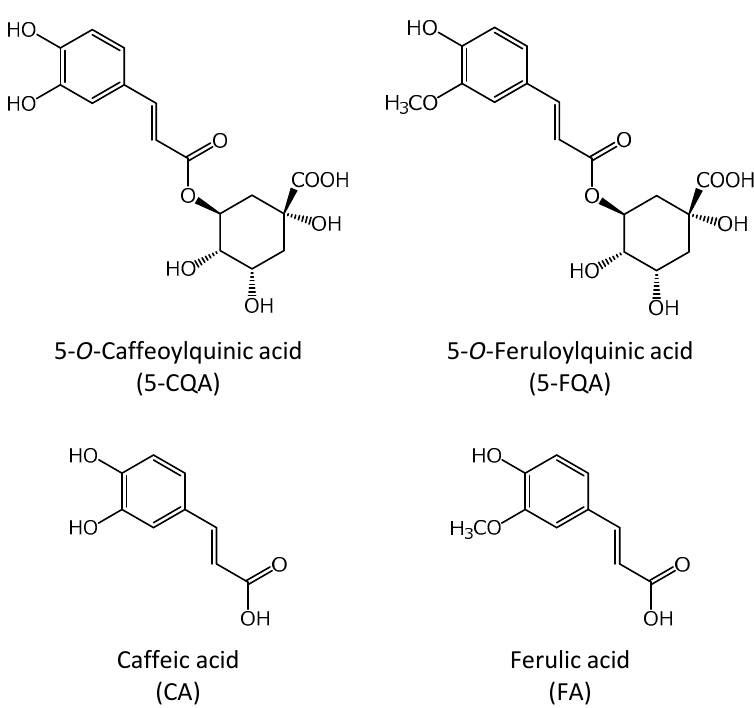
Figure 1. Structures of the chlorogenic acids (CGAs) evaluated in this study.